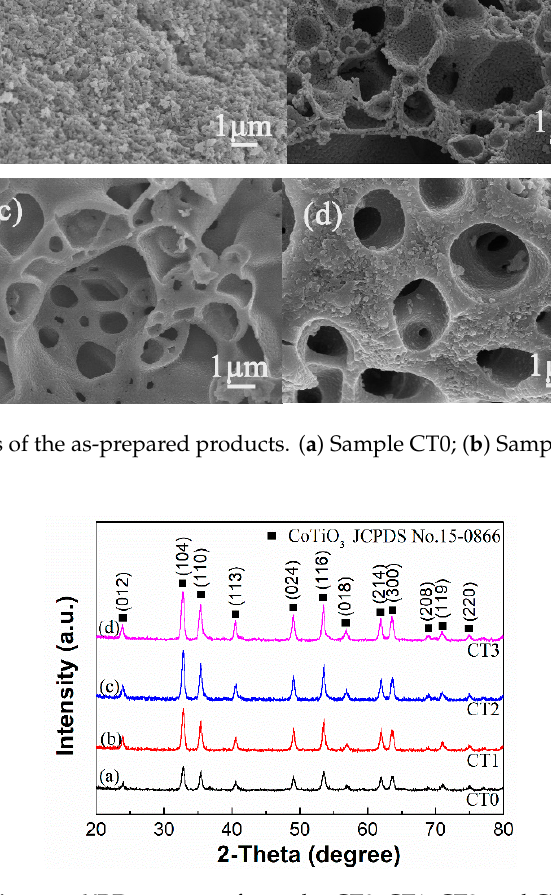
Figure 3. XRD patterns of samples CT0, CT1, CT2, and CT3.